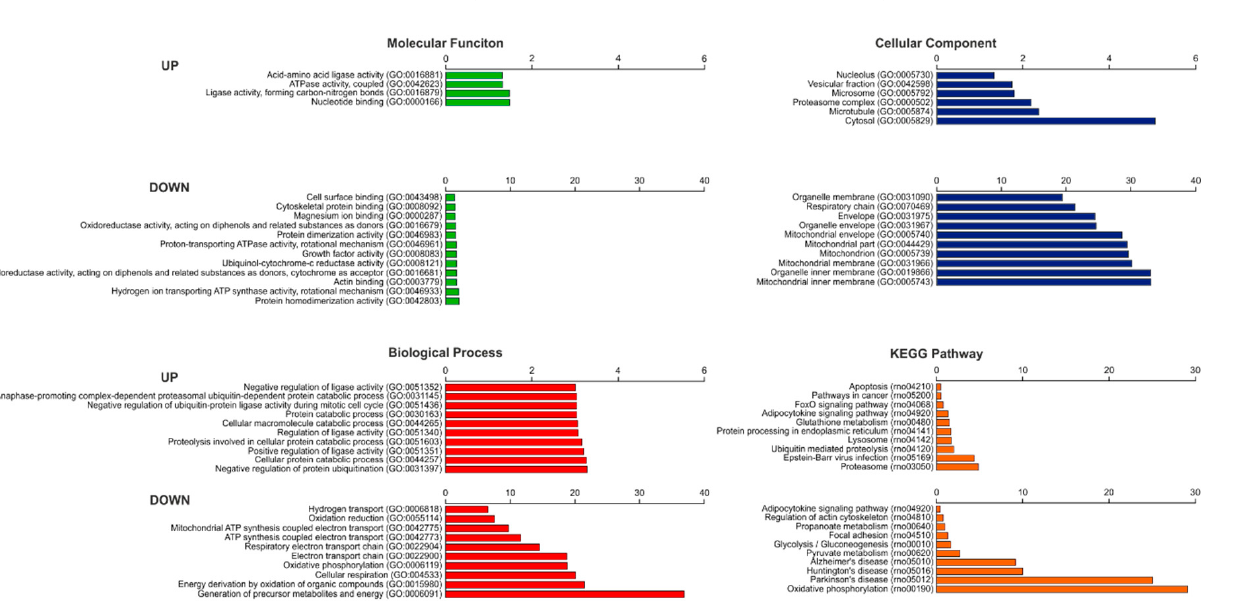
Figure 3. Gene Ontology (GO) enrichment annotation analysis of differentially expressed (DE) genes. GO categorization of DE genes in molecular functions (MF), cellular components (CC), biological processes (BP), and Kyoto Encyclopedia of Genes and Genomes (KEGG) Pathway (shown as -log 10 p -value). Only the top ten significant upregulated and downregulated annotations are shown ( p <